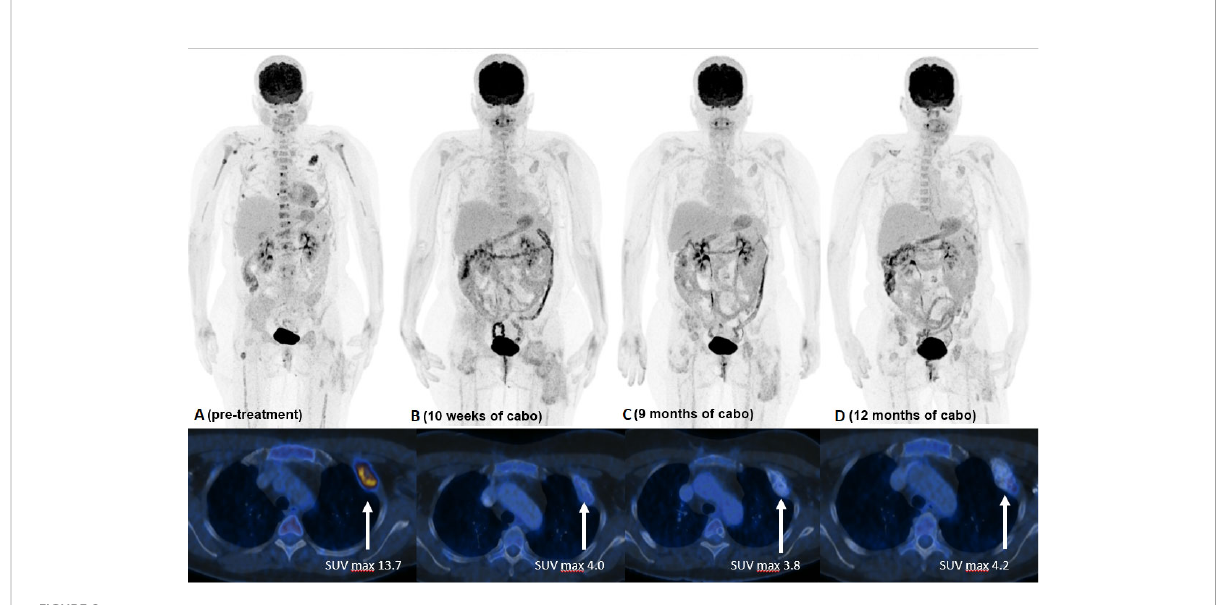
FIGURE 2 FDG PET/CT [ (A) 7/21] with multiple FDG avid bone metastases (ribs, spine, femurs, humerus, skullcap). SUV max, in the large left sided rib metastasis 13.7. FDG PET/CT [ (B) 10/21] 10 weeks after start of TKI treatment with reduction of uptake in all bone metastases (rib lesion reduction to SUV max. 4.0). No new FDG avid lesions visible. FDG PET/CT [ (C) 4/22] 9 months and [ (D) 7/22] 12 months after TKI start with ongoing good